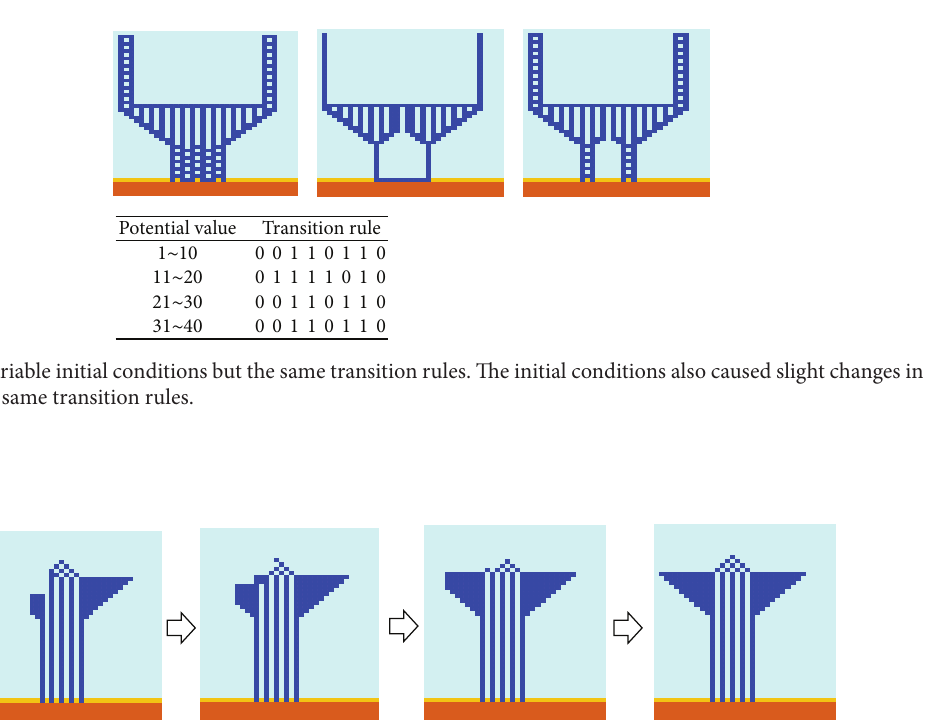
Figure 11: Result of the self-repairing process. The case of a damaged structure which is replaced by the grid state of the complete structure from 0 to 1 shows the capability of self-repairing a